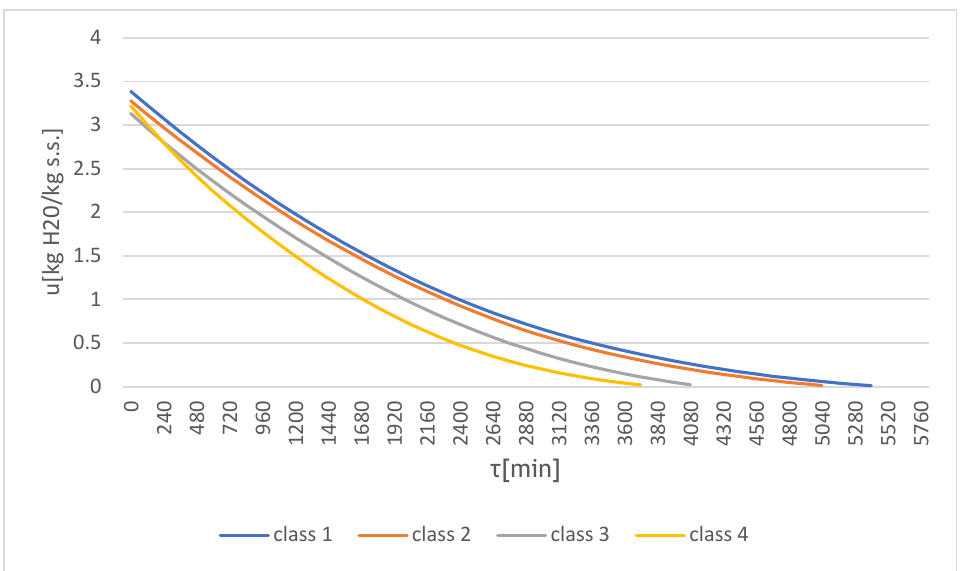
Figure 1. Curve of water content per time unit u( τ ) at 60 °C (class 1), 70 °C (class 2), 80 °C (class 3), and 90 °C (class 4).